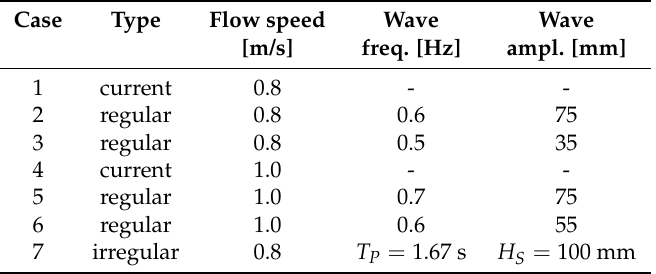
Table 3. Summary of the test matrix. The wave parameters are the required ones, that is, in every tank these characteristics have to be adjusted to account for the flow velocity (amplitude) or the carriage motion (frequency).